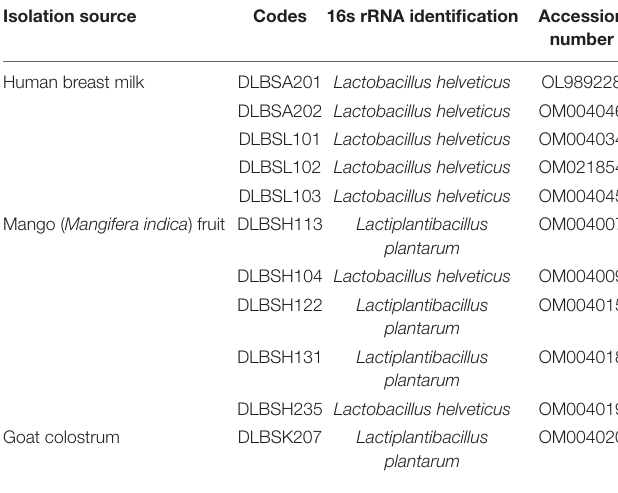
TABLE 1 | List of Lactobacillus isolates used in this